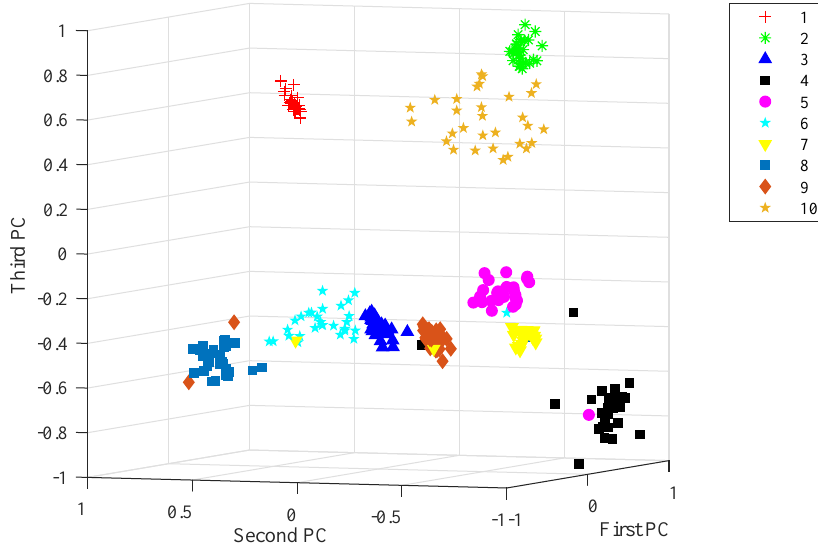
Figure 10. Features extracted by the model under cross-load level conditions.